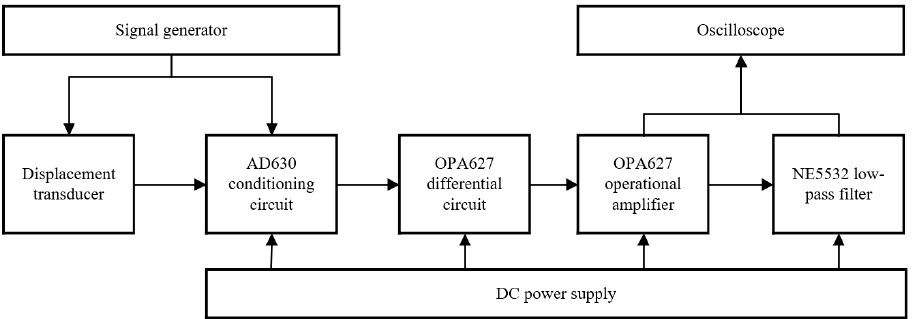
Figure 11. Experimental test block Figure 11. E xperimental test block diagram.